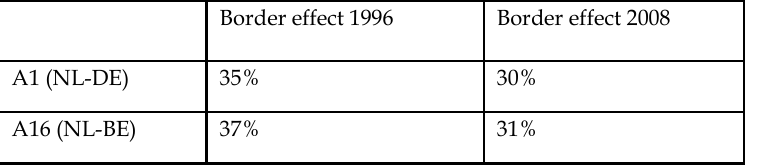
Table 2. Border effects on international highways, measured by means of B3 Border effect 1996